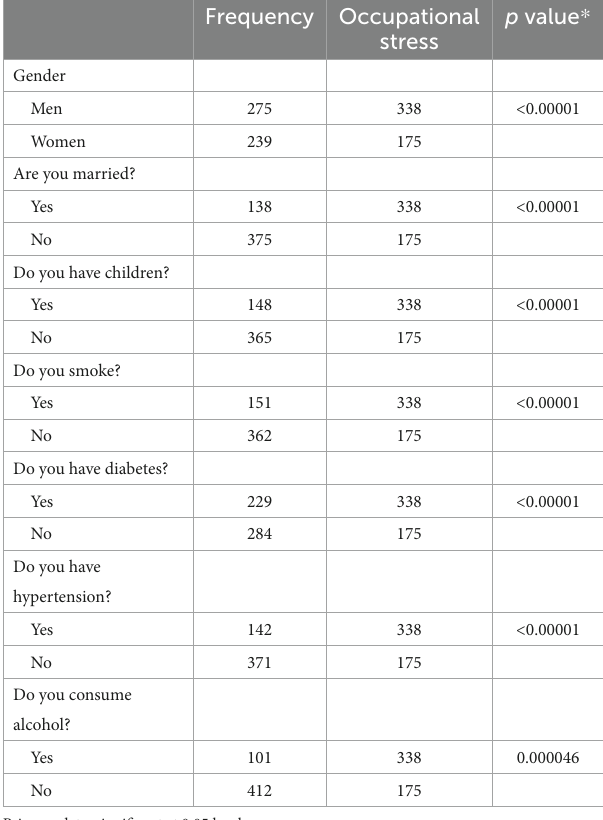
TABLE 4 Association between occupational stress and general